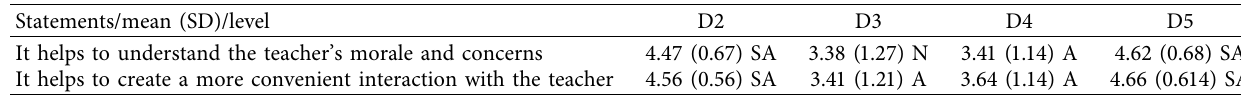
Table 4: Mean, standard deviation, and level of statements of the fourth parameter (students-instructors interaction), according to the Likert scoring method where SA is referred to strong agree, A is referred to agree, and N is referred to neutral. Statements/mean